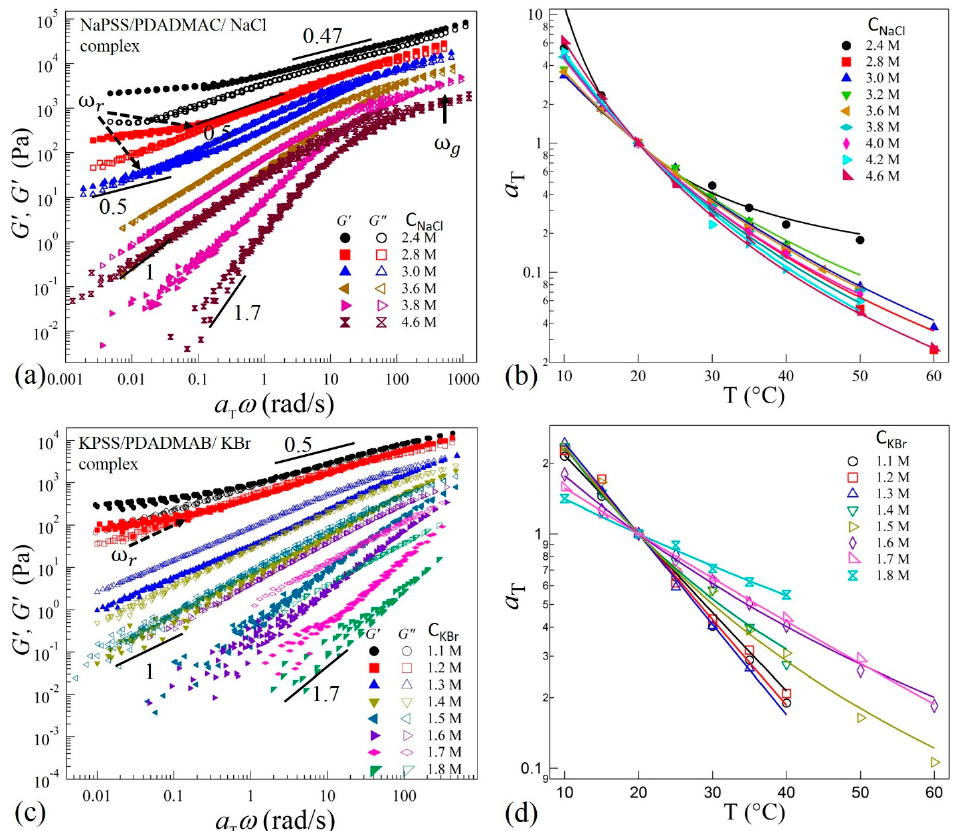
Figure 3. Plots of master curves and corresponding shift factors a T obtained after performing TTS of frequency-dependent viscoelastic moduli G ’ and G ” with T r = 20 ◦ C for complexes prepared at varying concentrations of ( a , b ) NaCl. Data for C NaCl = 2.8 M and 2.4 M are shifted vertically upward by a multiplicative factor 2 for clarity, and ( c , d ) KBr. The solid lines in ( b , d ) are fit to the WLF equation.